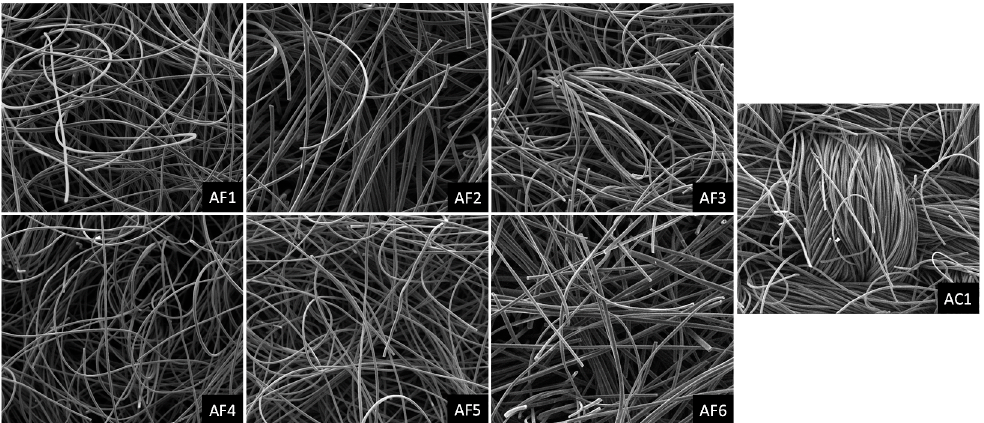
Figure 2. SEM images of activated carbon fibers (ACF) at 200 × magnification. ACF felt types (AF1 to AF6); ACF cloth type (AC1).